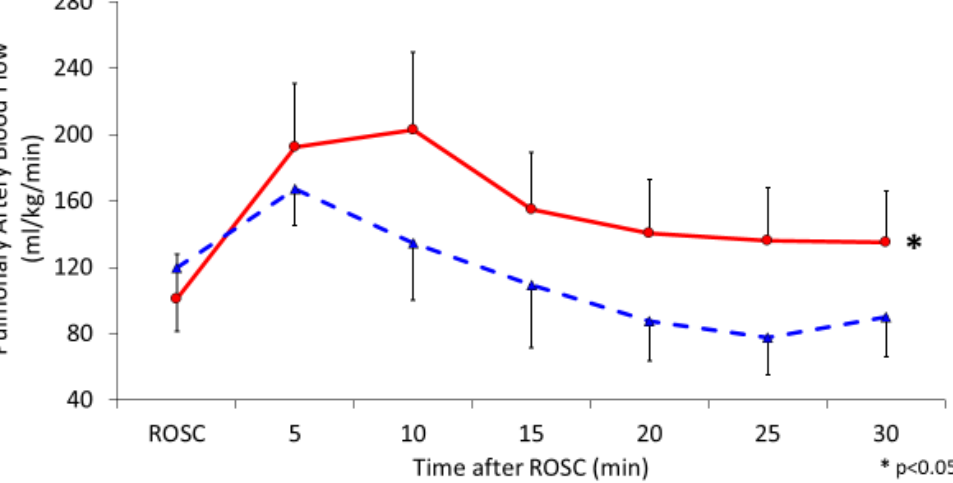
Figure 5. Interrupted line represents 21% and continuous line 100% oxygen. Data presented as average and standard deviation. ( A ) Pulmonary blood flow in mL/kg/min during CC. ( B ) Pulmonary blood flow after ROSC.